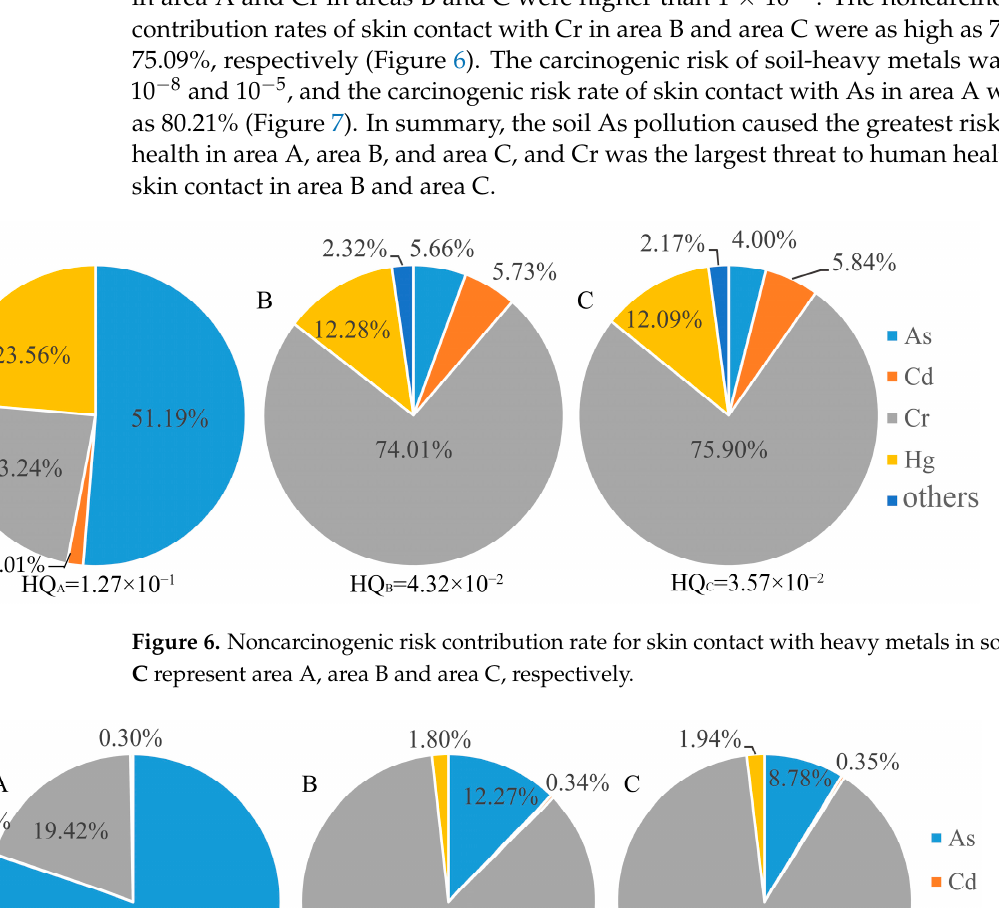
Figure 5. Carcinogenic risk contribution rate for oral intake of heavy metals in soil. A, B and C represent area A, area B and area C, respectively.